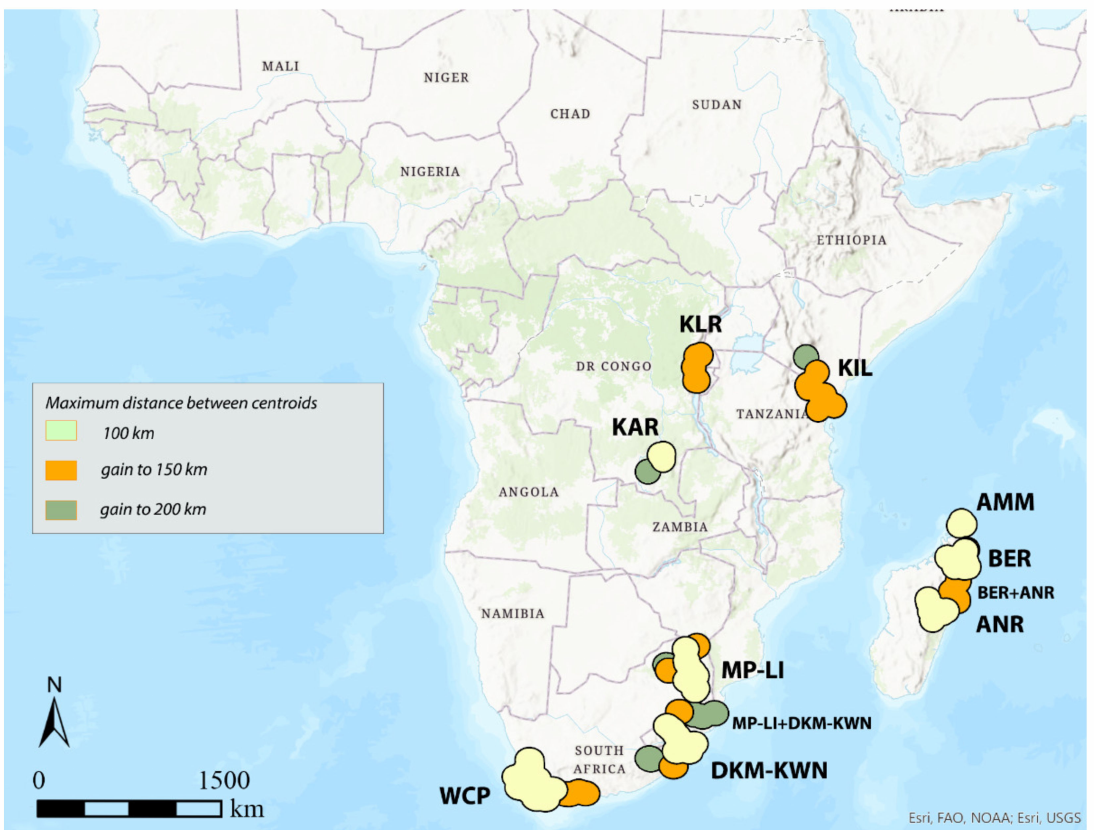
Figure 4. Areas of endemism detected by DBSCAN using species with distribution range up to 100 km and distance between centroids of 100, 150, and 200